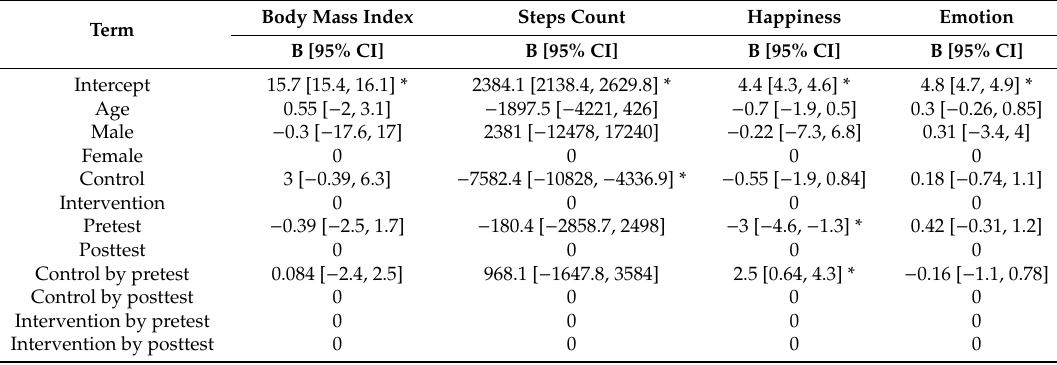
Table 2. Regression coe ffi cients of body mass index, steps count, happiness and emotion.